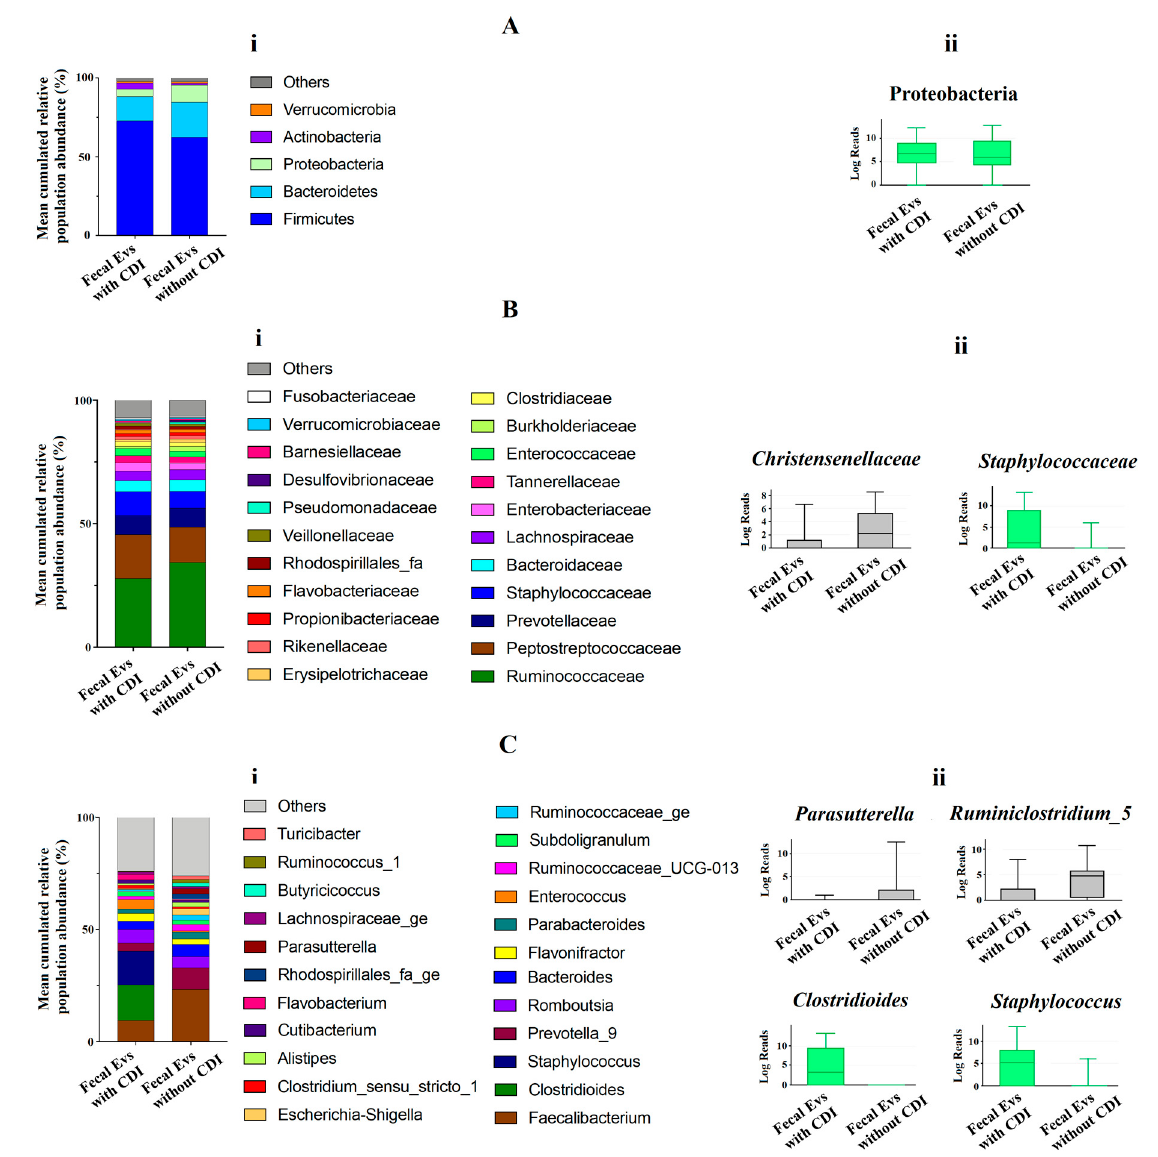
Figure 2. ( Ai , Bi , Ci ) Metagenomics profiles of fecal EVs isolated from patients with and without C. difficile infection (CDI). ( Ai ) Composition at phylum level with bar chart detailing the mean cumulative relative abundance (%) of the top 5 phyla common to the two patient groups. ( Bi ) Composition at family level with bar chart detailing the mean cumulative relative abundance (%) of the top 22 bacterial families common to the two patient groups. ( Ci ) Composition at genus level with bar chart detailing the mean cumulative relative abundance (%) of the 23 core genera common to the two groups of patients. Only phyla, families and genera with relative abundance >1% were plotted. ( Aii , Bii , Cii ) Box plots showing bacterial phyla ( Aii ), families ( Bii ) and genus ( Cii ) whose relative abundances were >1% and with statistical differences between fecal EVs isolated from patients with CDI and without CDI. Results of DESeq2 with Benjamini–Hochberg FDR corrections. Log Reads: Log2 relative normalized abundance. Staphylococcaceae, Staphylococcus and Clostridioides appear in green since they are a part of the 10 genera with the highest relative abundance in the analyzed samples.